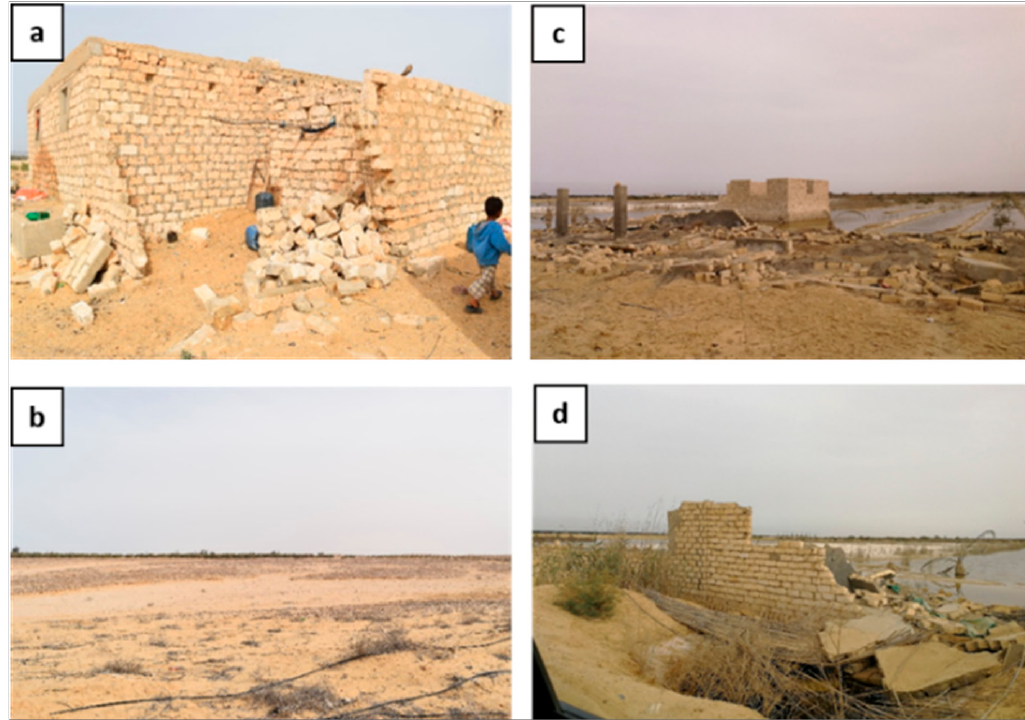
Figure 3. Consequences of a flash flood at Afouna Village: ( a ) damage to property, ( b ) one of the main flood stream paths in the village, ( c ) destruction of agricultural land, ( d ) wall collapsed in the main road.